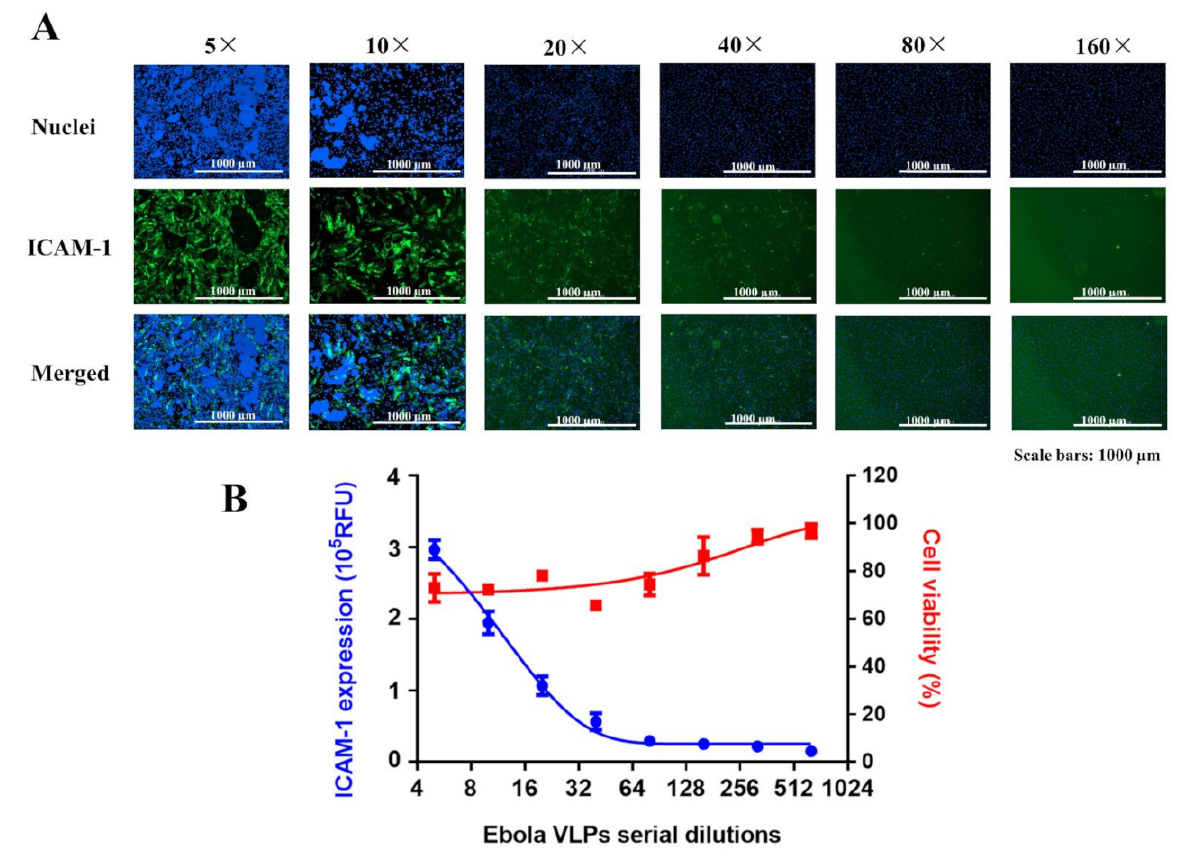
Figure 2. Ebola VLPs activate ECs in a dose-dependent manner. ( A , B ) ECs were treated with serial dilutions of VLPs for 48 h, fixed, and permeabilized for detection by immunofluorescence using an antibody directed against ICAM-1. Cell viability was determined using the Cell Counting Kit-8 assay. ( A ) Immunofluorescence images are shown for each VLPs dilution factor. ( B ) Dose-dependent curves showing induced ICAM-1 expression (blue) and cell viability (red). Data are representative of two independent experiments ( n = 3). VLPs: virus-like particles; ECs: endothelial cells; ICAM-1: intercellular adhesion molecules